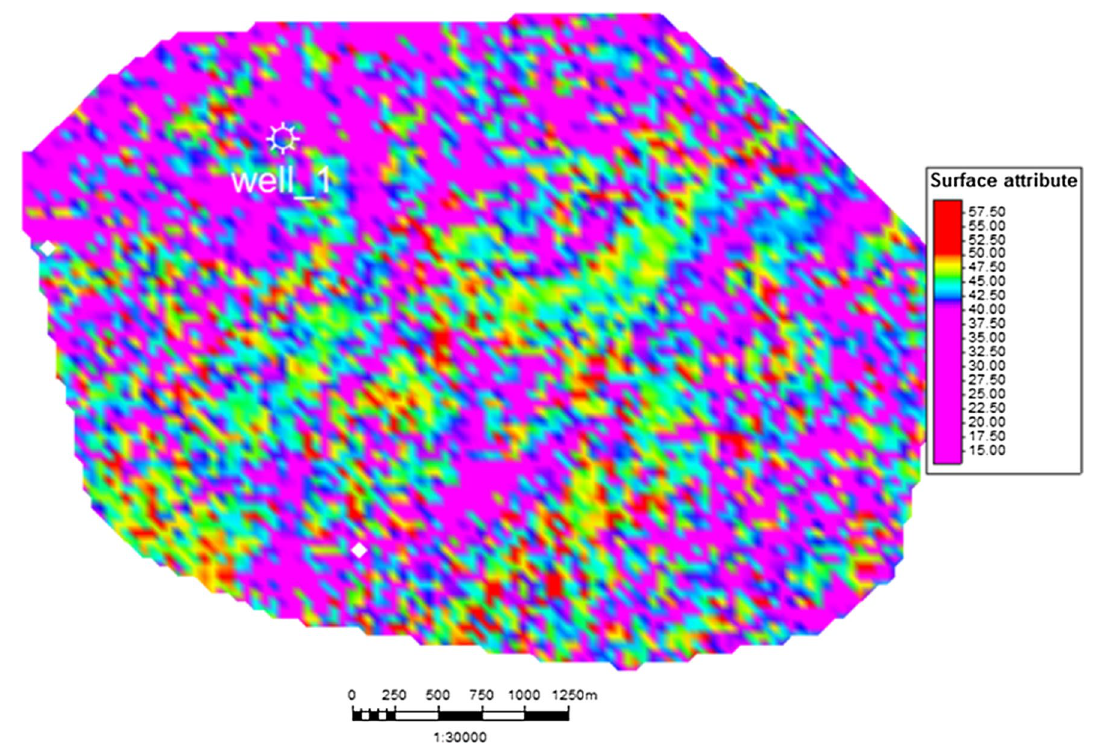
Fig. 11 Surface amplitude map, extracted from a dominant frequency volume